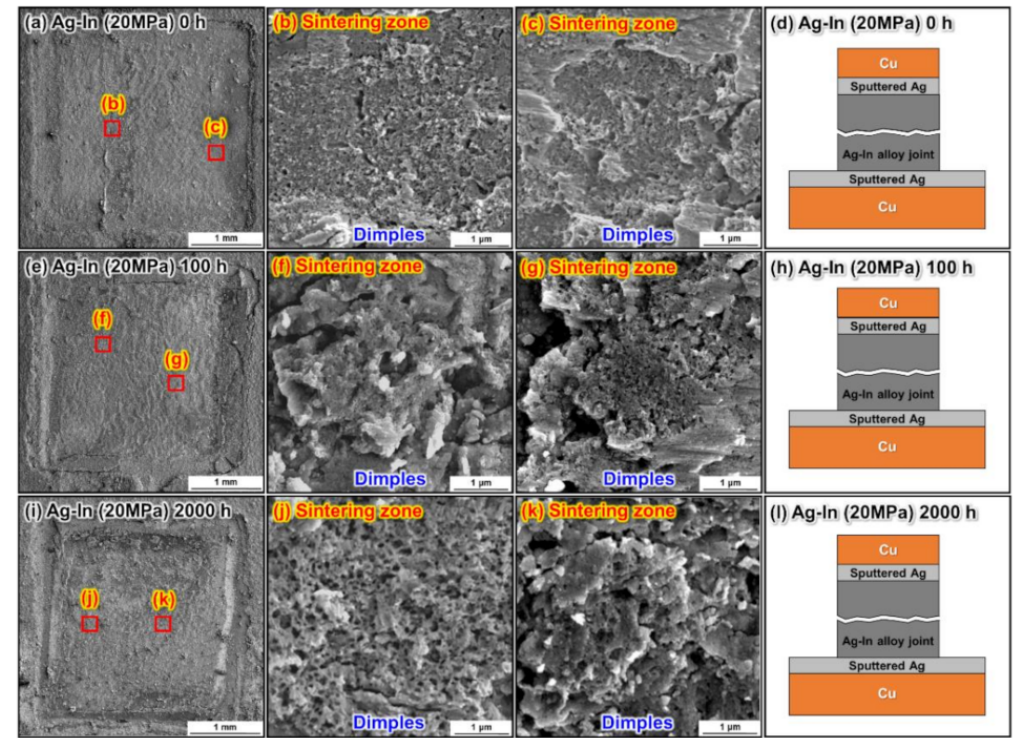
Figure 15. Surface fracture analysis of the sintered Ag–In alloy joints bonded at 20 MPa. Fracture planes of the Ag–In alloy joints ( a ) as-bonded and after ( e ) 100 h and ( i ) 2000 h of HTS at 300 ◦ C. ( b , c ), ( f , g ), and ( j , k ) are magnified images of the fracture plane areas marked in ( a , e ), and ( i ), respectively. Schematic of the crack propagation in the sintered Ag–In alloy joints bonded at 20 MPa ( d ) as-bonded and after ( h ) 100 h and ( l ) 2000 h of HTS at 300 ◦